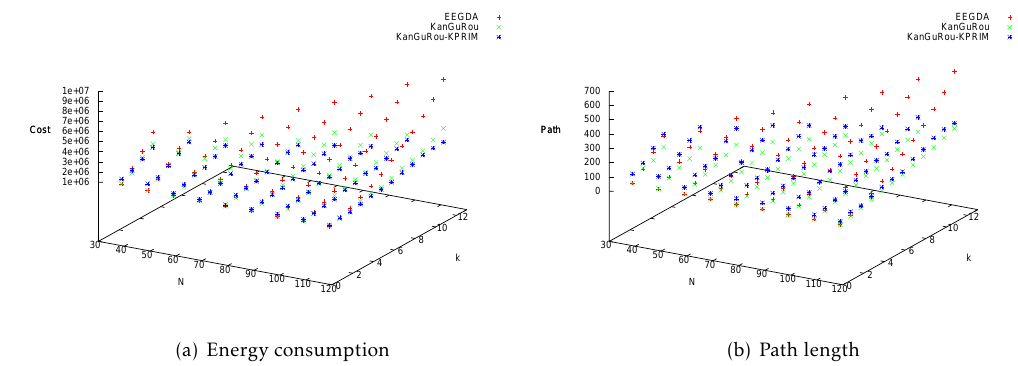
Figure 5. Algorithms performances with regards to N and k for M = 10% × N .